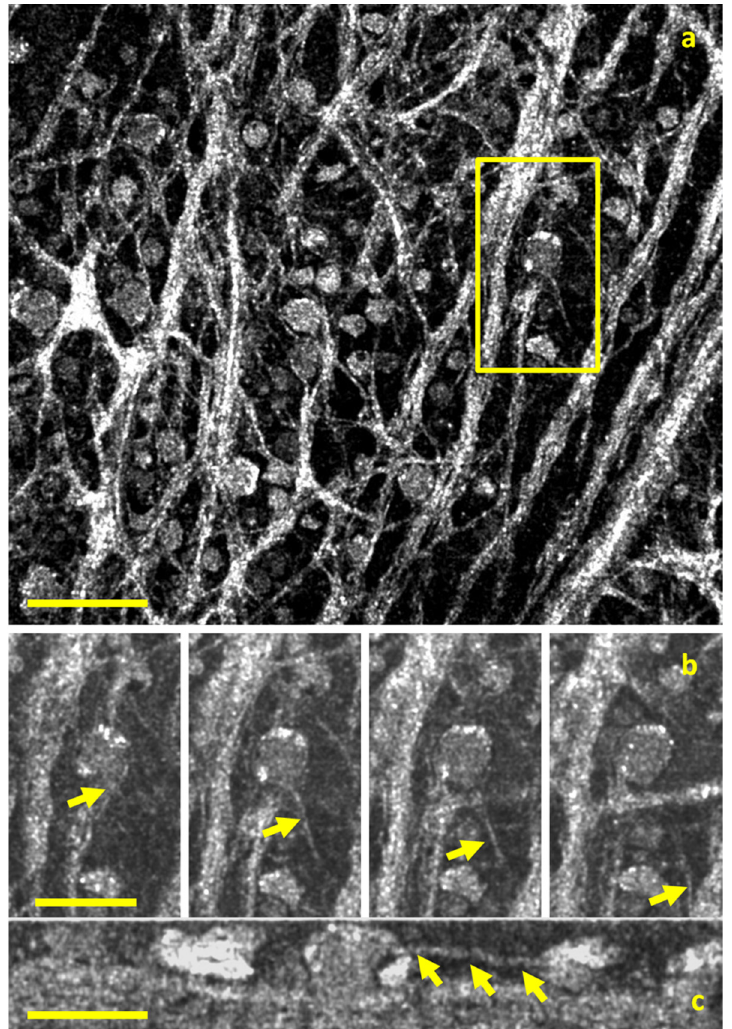
Figure 5. Full-field optical coherence tomography (FF-OCT) imaging the human retina. ( a ) The en face view of the human nerve fiber layer (scale bar is 500 μ m). ( b ) A four-panel image of a 2 μ m thick axon (yellow arrow) moving away from a ganglion cell soma. ( c ) A cross-section the same cell in ( b ) along the length of the axon (scale bar is 50 μ m). Reprinted with permission from Grieve et al. [25]. Appearance of the Retina With Full-Field Optical Coherence Tomography. Invest. Ophthalmol. Vis. Sci. 2016; 57(9): OCT96-OCT104 with license permissions obtained from Creative Commons; Creative Commons Attribution-NonCommercial-NoDerivatives 4.0 International (CC BY-NC-ND